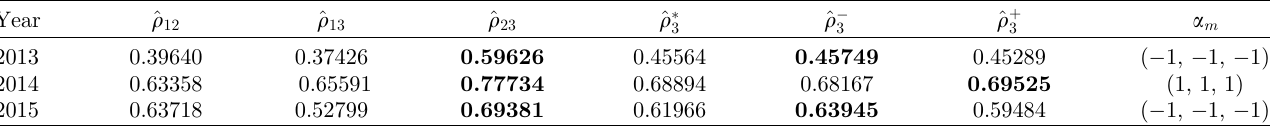
Table 5. Estimation of coef fi cients. On the left the bivariate Spearman ’ s rho coef fi cients (in bold letter the largest), on the right the trivariate correlations (in bold letter the largest), a m shows the direction of maximal dependence. Calculus I (subscript 1), Mathematics (subscript 2) and Natural Sciences or Physics (subscript 3).